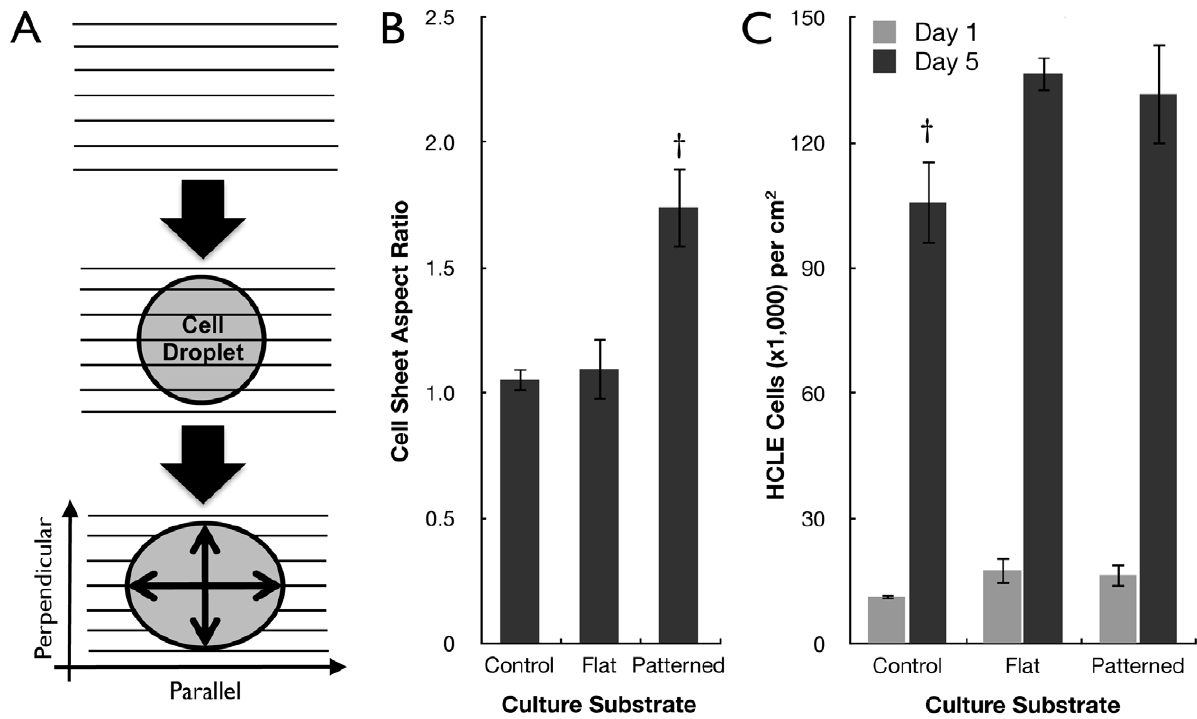
Figure 2. Cell sheet growth directed by silk topography. (A) Schematic demonstration of a cell droplet forming a collective sheet that disperses parallel to the patterned silk feature axis as measured by the culture length to width aspect ratio, with parallel versus perpendicular directions defined. (B) The aspect ratios of cell sheets on patterned silk surfaces after 1-day in culture (n=4, { indicates p , 0.05 when compared other substrates, error bars=SD). (C) Cell proliferation on various surfaces at 1-day and 5-days in culture as quantified by nucleic acid content (n=3, { indicates p , 0.05 when compared to other substrates of similar group, error bars=SD).